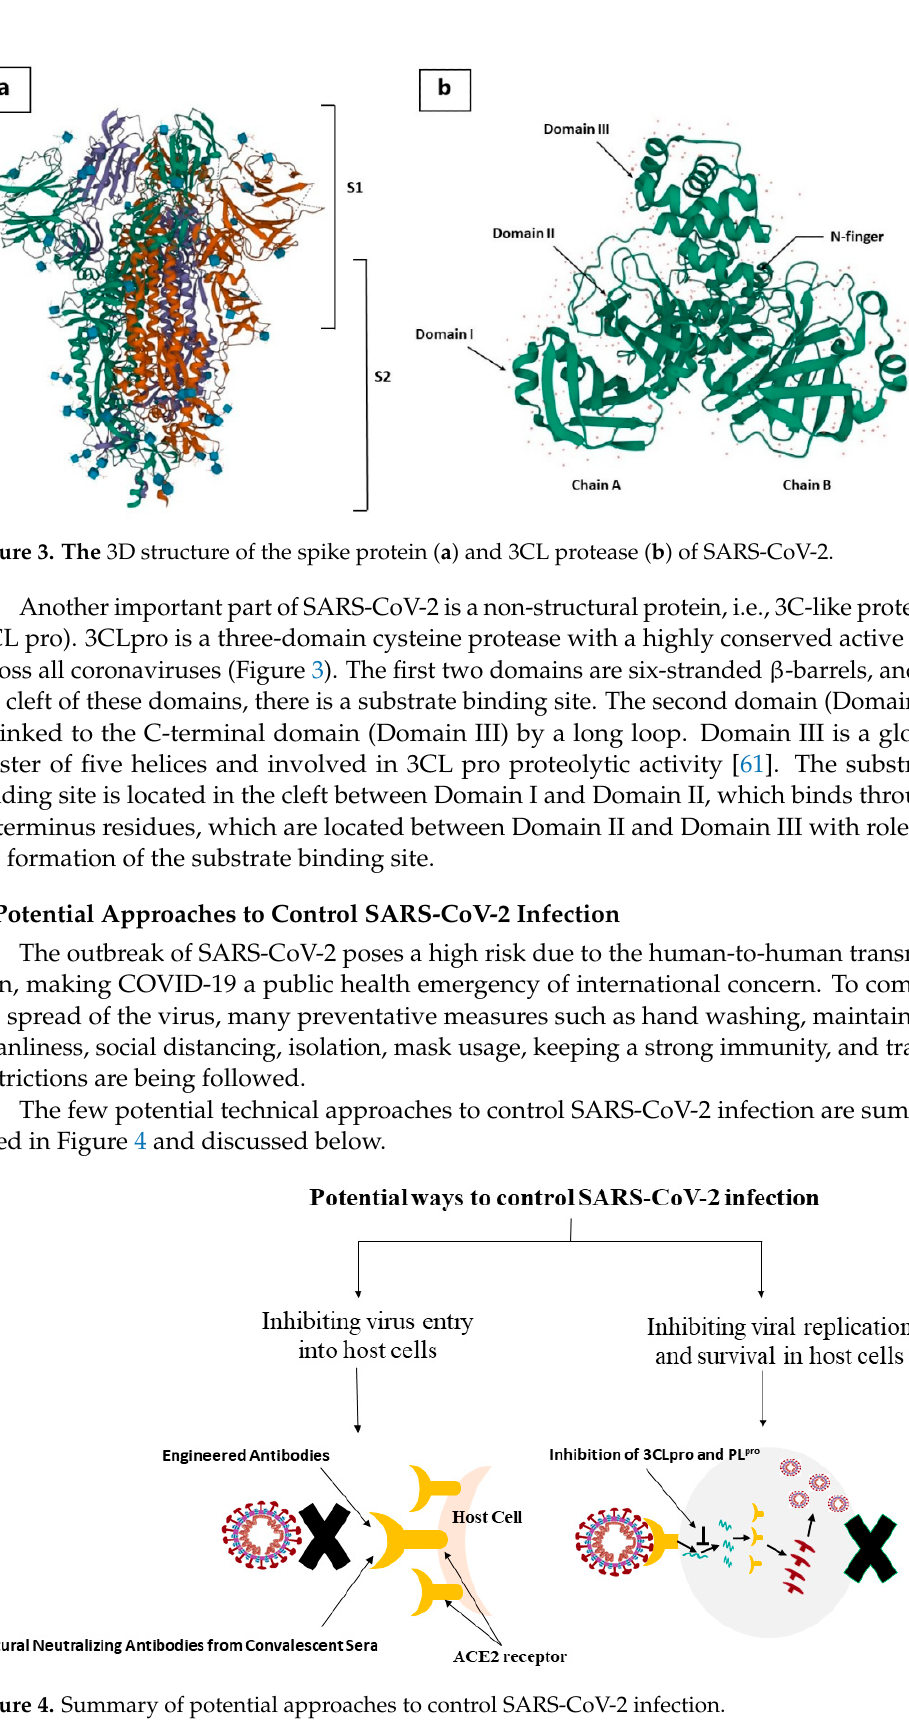
Figure 4. Summary of potential approaches to control SARS-CoV-2 infection.